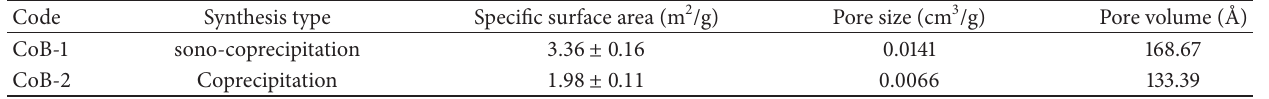
Table 1: Texture properties of Co-B